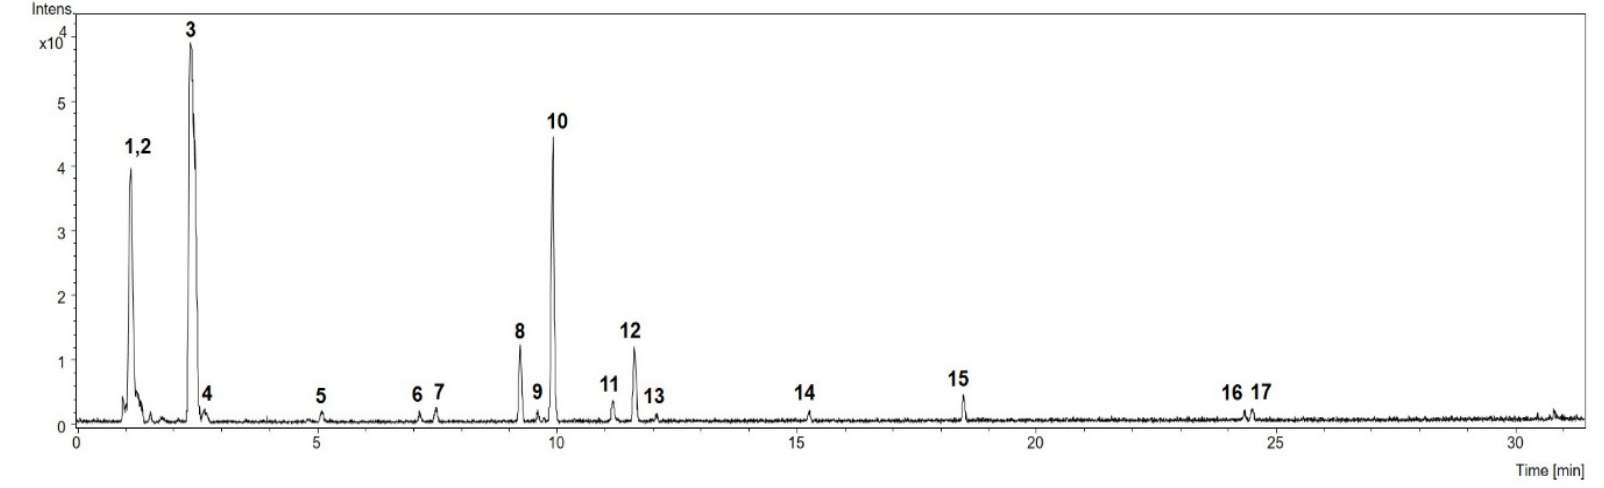
Figure 2. The base peak chromatogram (BPC) obtained by UFLC–DAD–MS of M. citrifolia aqueous fruit extract (AE), in negative mode. The identification of chromatographic peaks is described in Table 2. Table 2. Compounds tentatively identified in M. citrifolia aqueous fruit extract (AE).